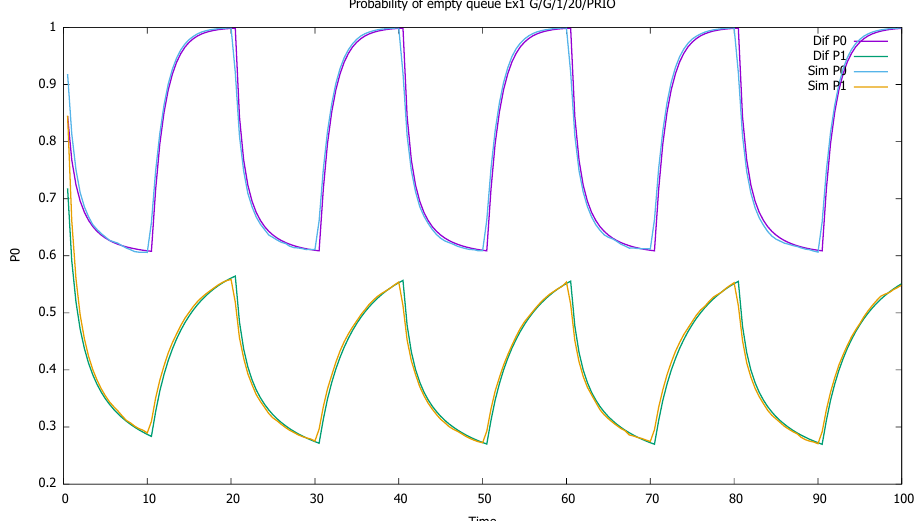
Figure 3. Section 3.1, low load: probabilities of empty queues for priority (P0) and non-priority (P1)